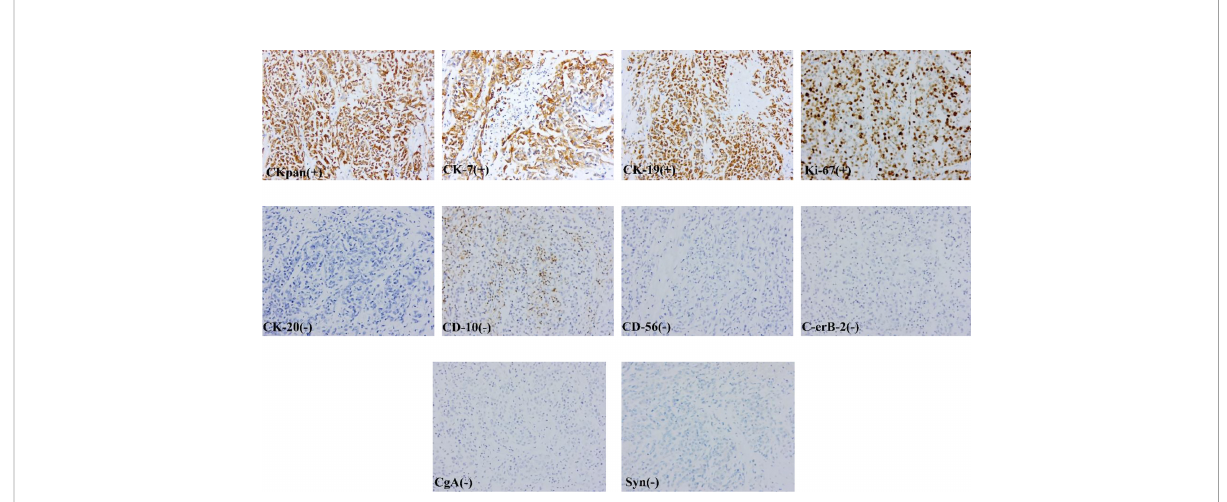
FIGURE 2 The tumor tissue expressed broad-spectrum cytokeratin (CKpan), CK-7, and CK-19, but not CK-20, C-erB-2, CD-10, CD-56, synaptophysin (Syn), chromogranin A